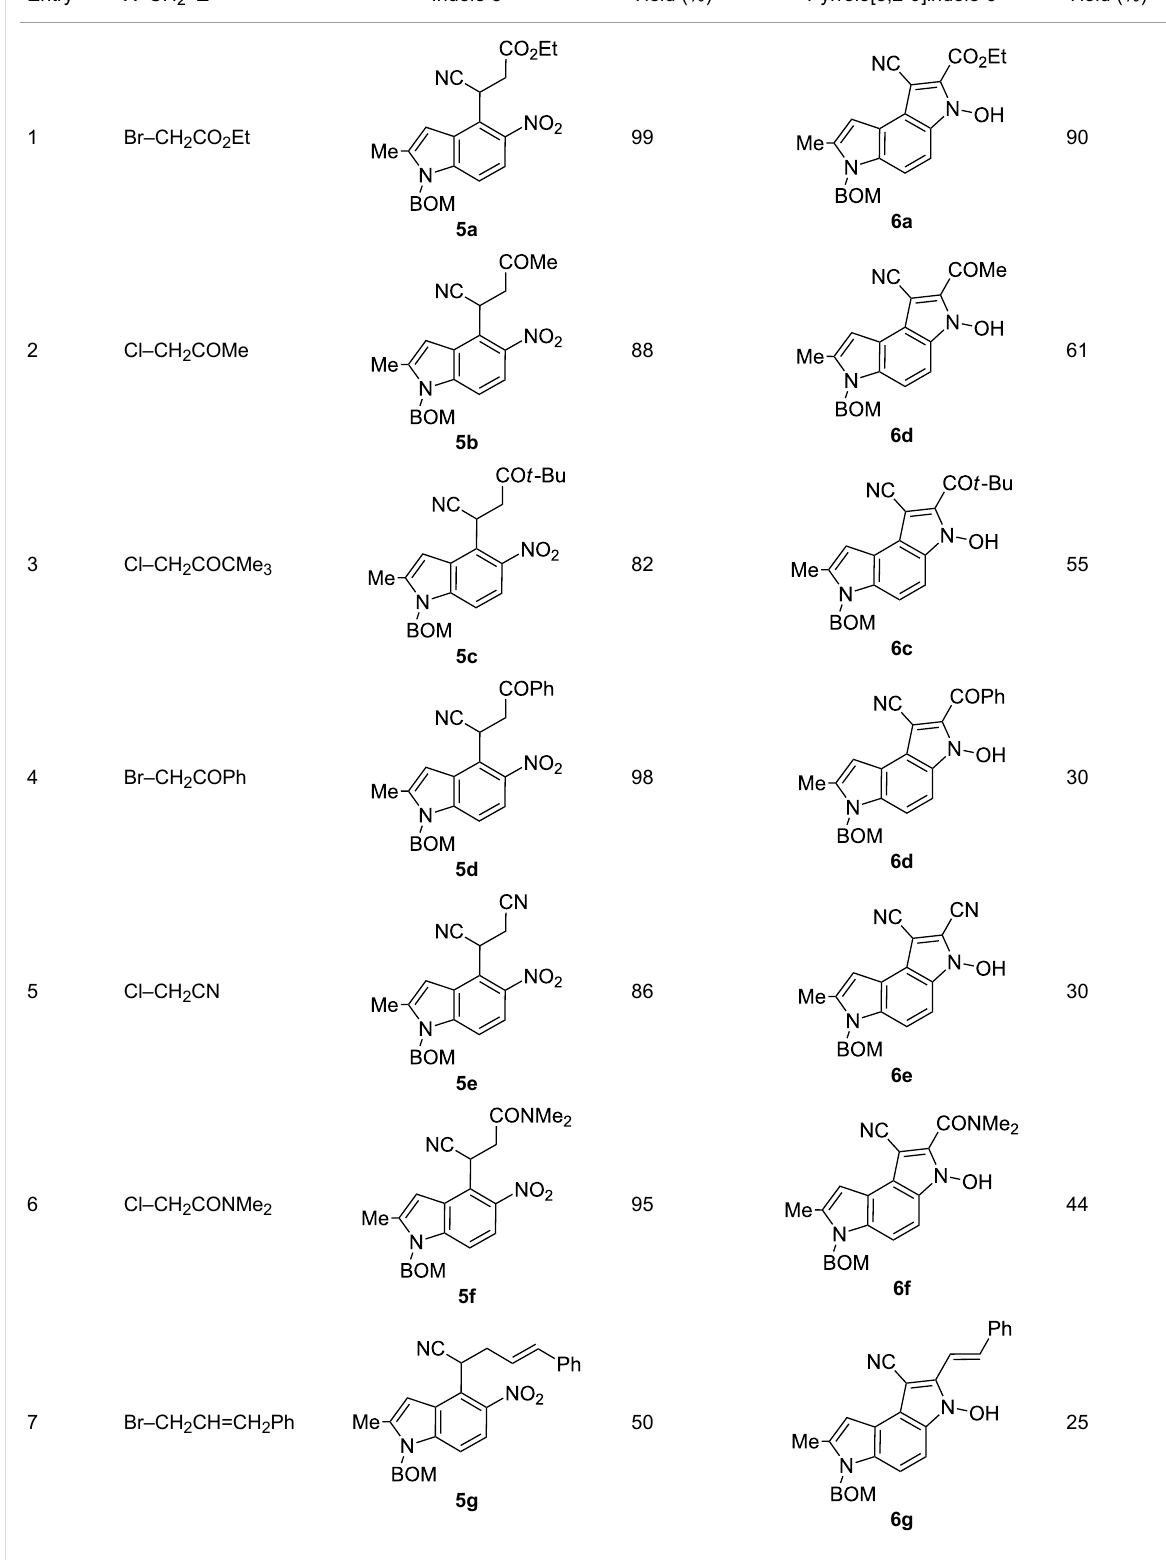
Table 1: Alkylation products 5 and synthesized 1-cyano-3-hydroxy-pyrrolo[3,2- e ]indoles 6